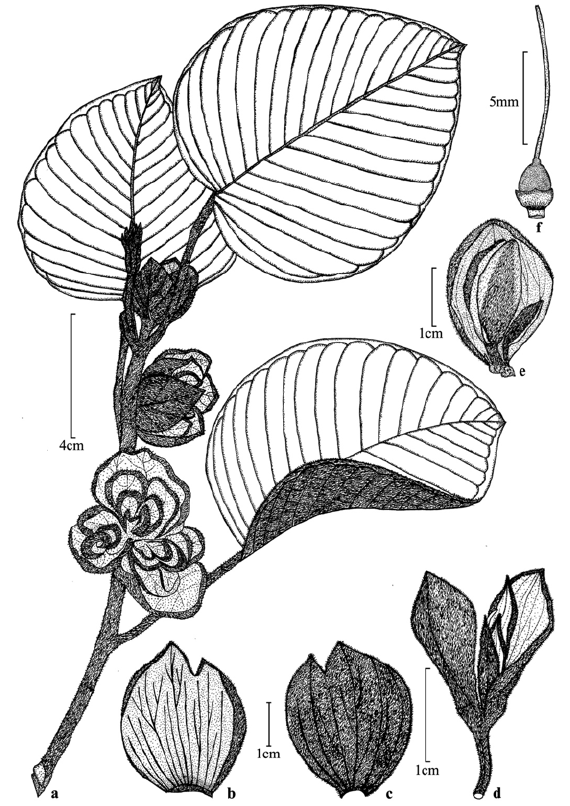
Figure 2. Argyreia wallichii Choisy: a—flowering twig | b - outer bract (adaxial view) | c—outer bract (abaxial view) | d—inner bract | e— outer and inner bracts arrangement